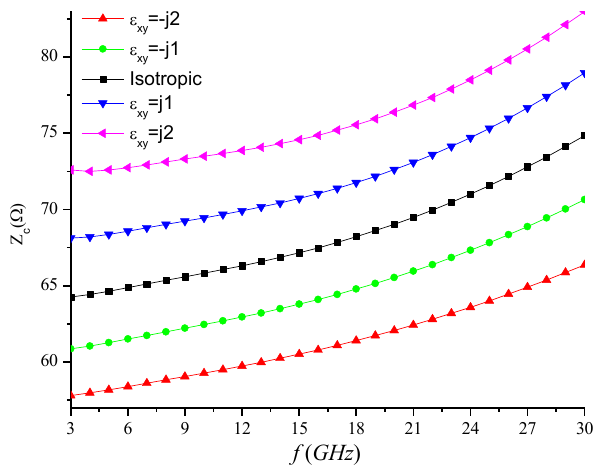
Figure 6.b: Effect of imaginary valued e xy on the characteristic impedance